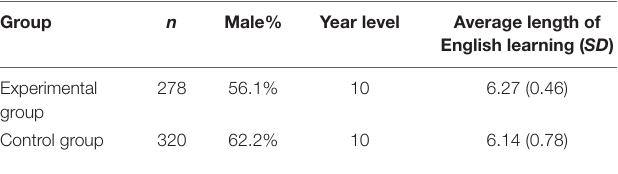
TABLE 1 | Participant demographic